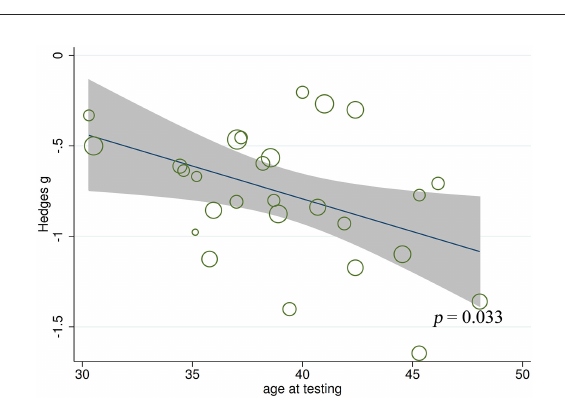
FIGURE8 Associations between aggregated effect sizes of the studies investigating FER performance and age at testing. FER, facial emotion